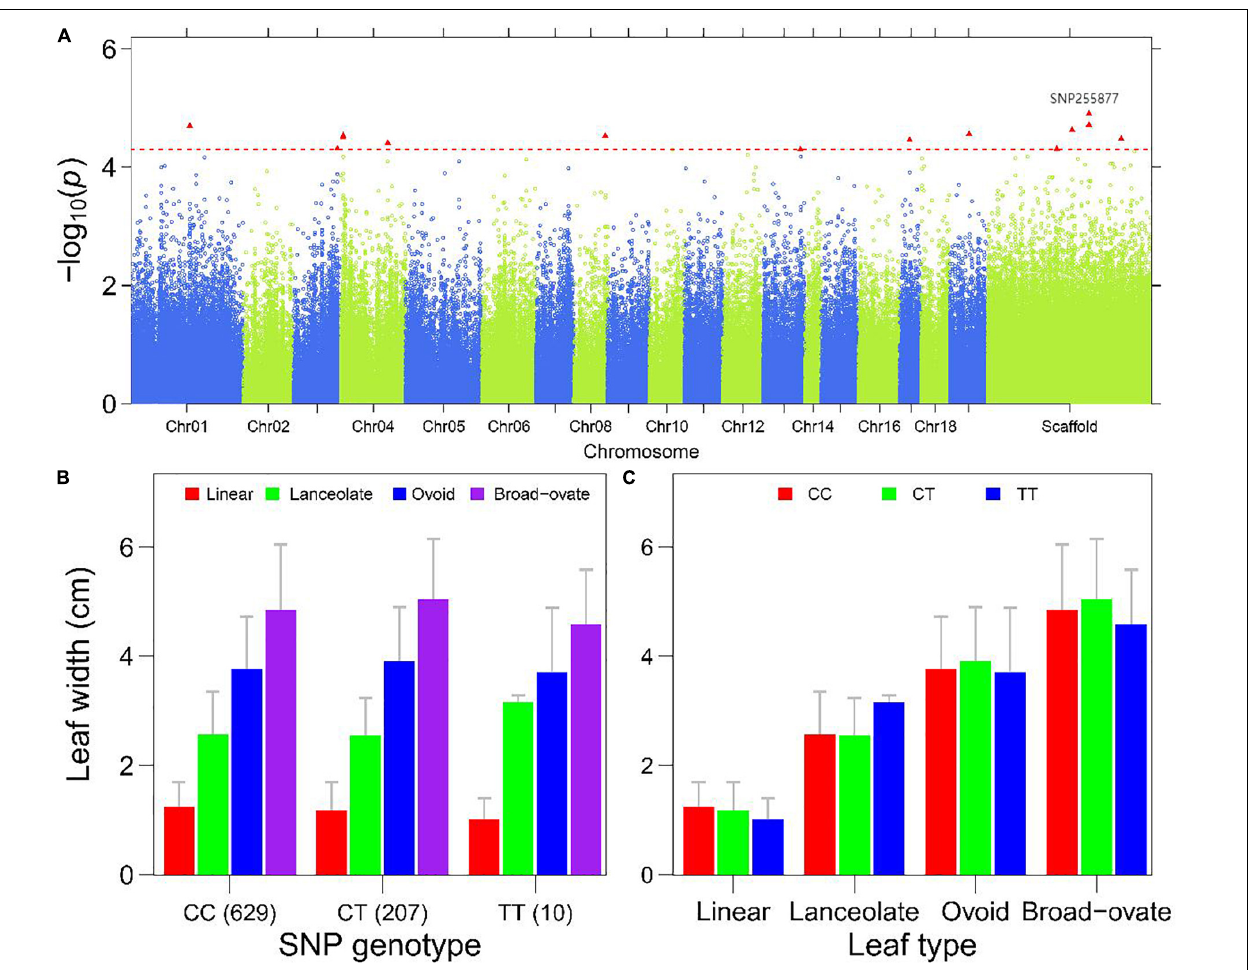
FIGURE 5 | Genome-wide association mapping of the leaf width in P. euphratica . (A) Manhattan plot displaying the GWAS result of the trait ‘leaf width’ based on the single-leaf GWAS. The significantly associated SNP markers are labeled. (B) Histograms of leaf width of different leaf types plotted as a function of genotypes at SNP255877. (C) Histograms of allelic effects of SNP255877 for the